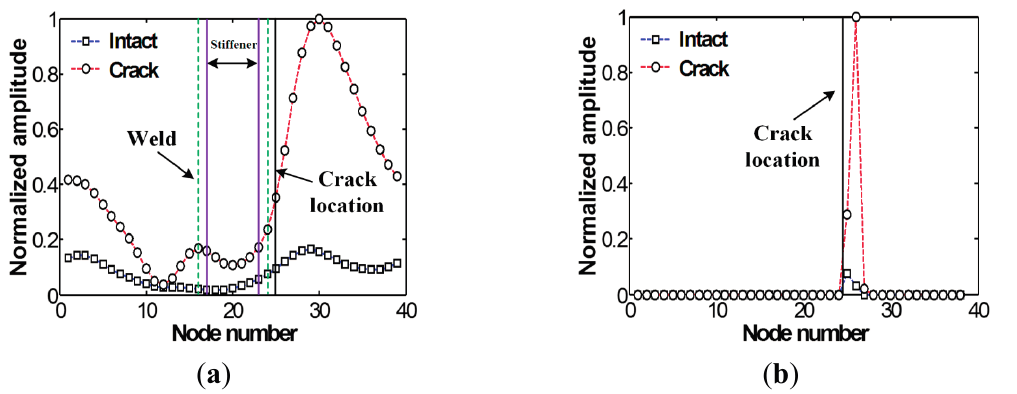
Figure 12. Spatial energy variations obtained from the FE models without and with the crack: ( a ) Filtered energy distributions and ( b ) the corresponding energy variations after spatial derivative and employing a threshold